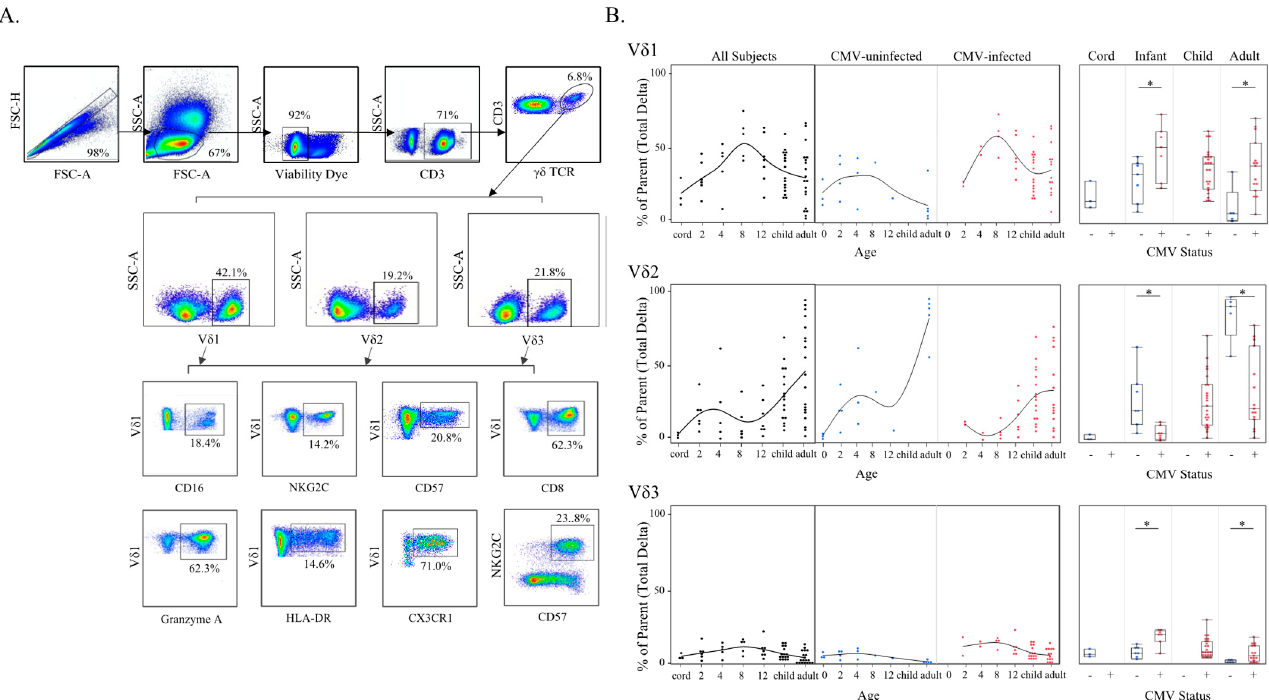
Figure 4. γδ T Cell δ -subsets change with age and CMV status. ( A ) Gating strategy for δ -subsets and phenotypes of γδ T cells using spectral flow cytometry. Initial flowCut cleaning in FlowJo was followed by singlet, lymphocyte, CD3 + and total γδ T cell gates. Next δ -subsets were gated as shown, and lastly each phenotypic marker was gated from V δ 1, V δ 2 and V δ 3 subsets (example gates are shown for V δ 1 T cells); ( B ) δ -subset frequencies (proportion of total γδ T cells) were plotted by age (left) and then additionally stratified by CMV status (center). These same data are shown on the right separated by